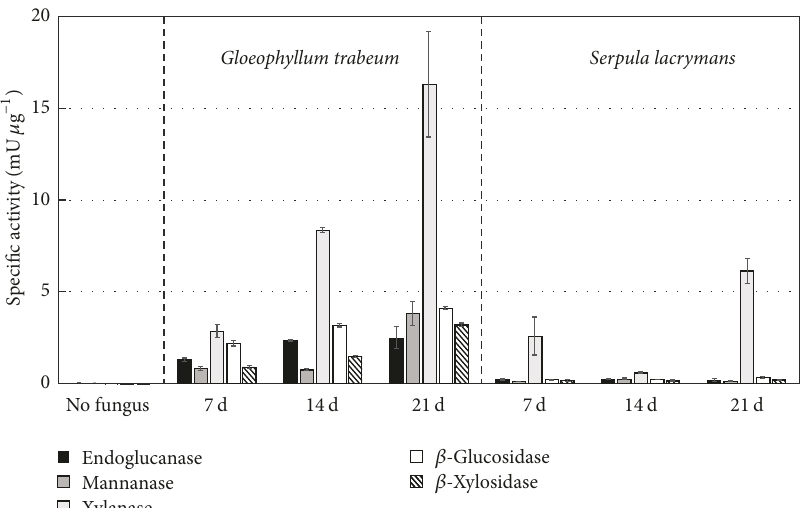
Figure 2: Endoglucanase, Xylanase, Mannanase, 𝛽 -glucosidase, and 𝛽 -xylosidase specific activities of protein extracts from sorghum sections degradedby Gloeophyllumtrabeum and Serpulalacrymans for7,14,and21daysandundegradedsorghumbiomass.Errorbarsare+/ − standard error of three replicate assays of each of two replicate